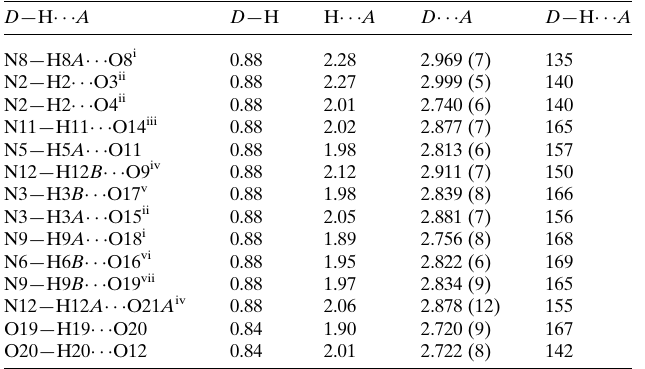
Table 1 Hydrogen-bond geometry (A˚ , (cid:4) ).